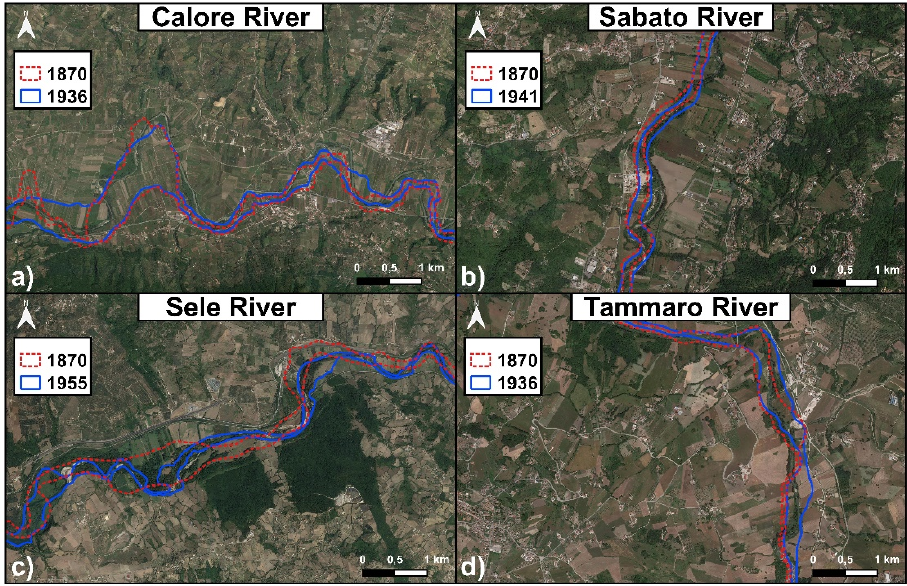
Figure 3. Geomorphological sketches of some selected river stretches showing channel width variations during Phase 1.